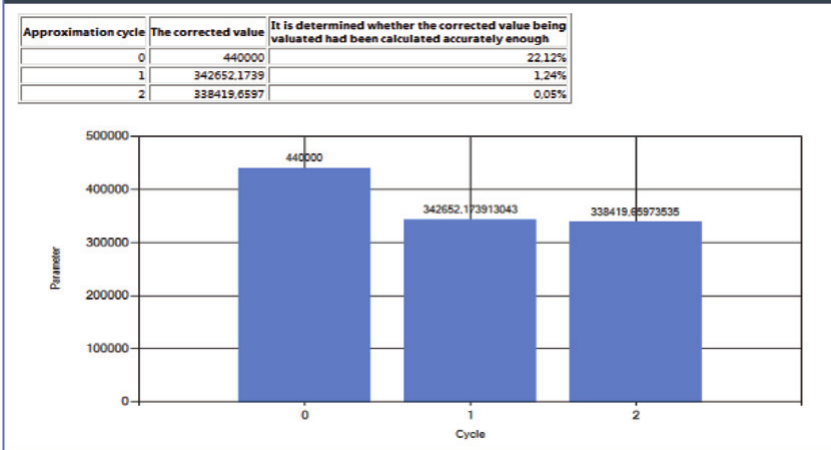
Fig. 6. Calculating the market value of a flat